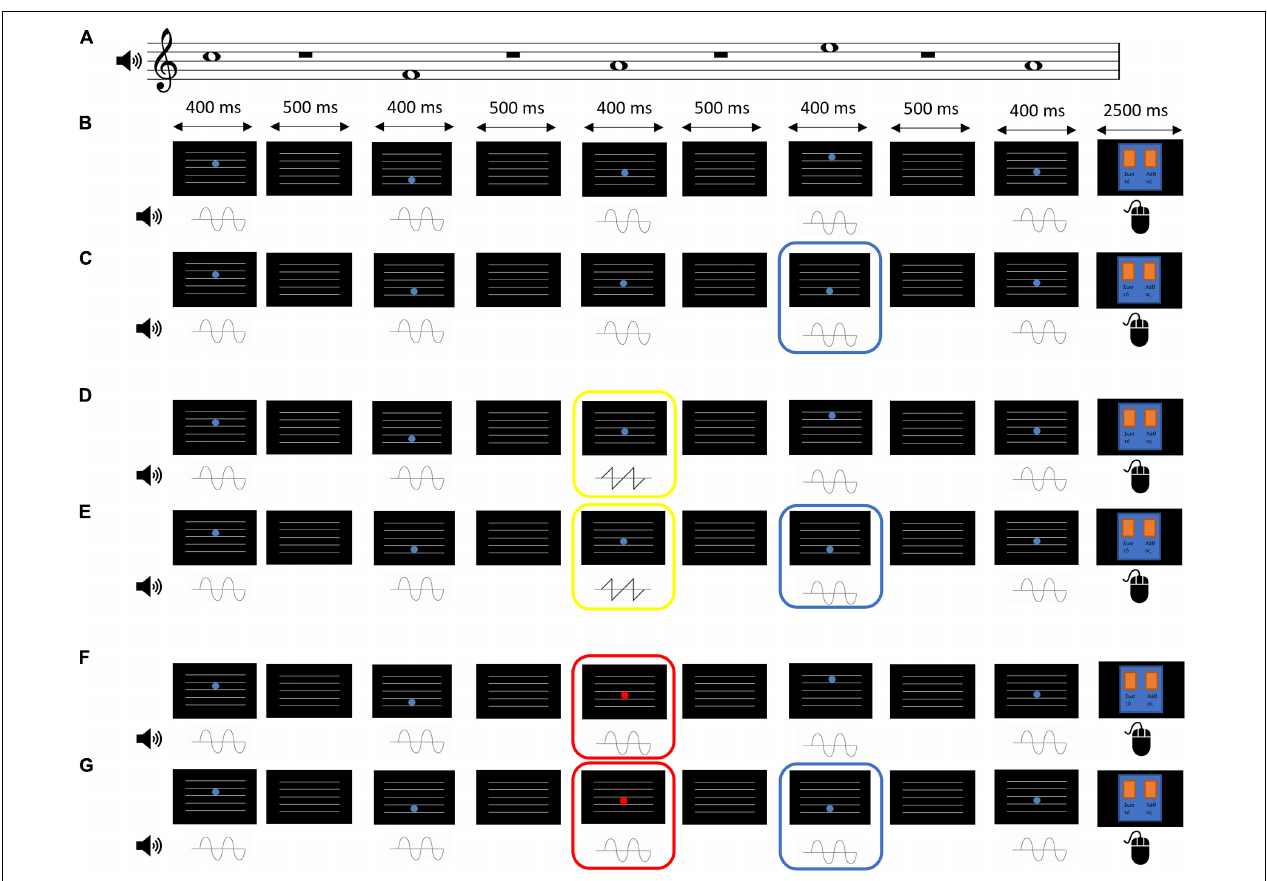
FIGURE 1 | Example trials from the EEG measurement task under all the possible conditions. Each trial presented a sequence of 5 tones paired with a disk that changed its position in height. Subjects were instructed to attend to the visual (disk) and the auditory stimulus (tone) congruence according the rule “the higher the pitch, the higher the disk position”. After each sequence, they were given 2.5 s to provide an answer by using the mouse, indicating whether the sequence was “correct” (left mouse button) or “incorrect” (right mouse button). Unisensory deviants were asked to be ignored. For the purposes of illustration, all examples below have the same tone sequence. (A) The pitch of the tones in the examples described below. (B) A trial that belongs to the Audiovisual congruence type. In this type, no audiovisual incongruence and no unisensory deviance are present. (C) A trial that belongs to the Audiovisual incongruence type. In this type, there is no unisensory deviance but one of the disks’ height (here, the one in the 4th position of the sequence, marked by the blue frame) does not match the tone’s pitch. (D) A trial that belongs to the Auditory deviance type. One of the tones (here, in the 3rd position, marked by the yellow frame) has a sawtooth timbre instead of a sine. In this trial type, an audiovisual incongruence may or may not be present (50% chance), but not overlapping with the auditory deviant. This example does not contain an audiovisual incongruence. (E) As (D) above, but this example contains an audiovisual incongruence in the 4th position (marked by the blue frame). (F) A trial that belongs to the Visual deviance type. One of the disks (here, in the 3rd position, marked by the red frame) appears in red color instead of blue. In this trial type, an audiovisual incongruence may or may not be present (50% chance), but not overlapping with the visual deviant. This example does not contain an audiovisual incongruence. (G) As (F) above, but this example contains an audiovisual incongruence in the 4th position (marked by the blue